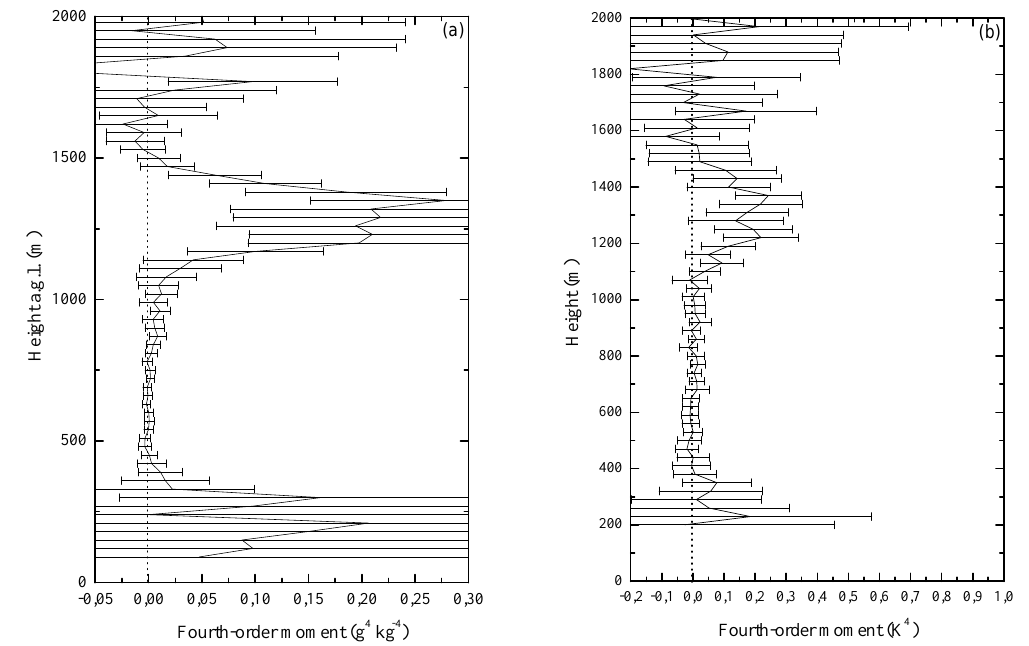
Figure 12. Vertical profiles of the fourth-order moment for water vapour mixing ratio (a) and temperature (b) computed for the same time interval considered in Fig. 4. In the figure the error bars represent only the noise